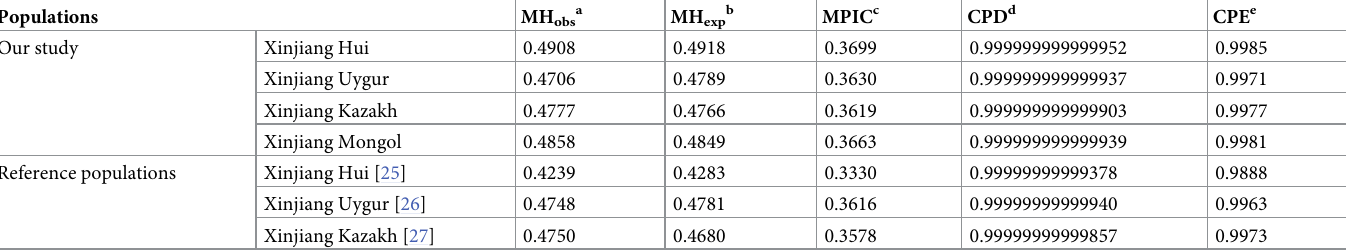
Table 1. Forensic parameters of the four ethnic minorities from Xinjiang in our study and three reference populations by the Investigator DIPplex kit.